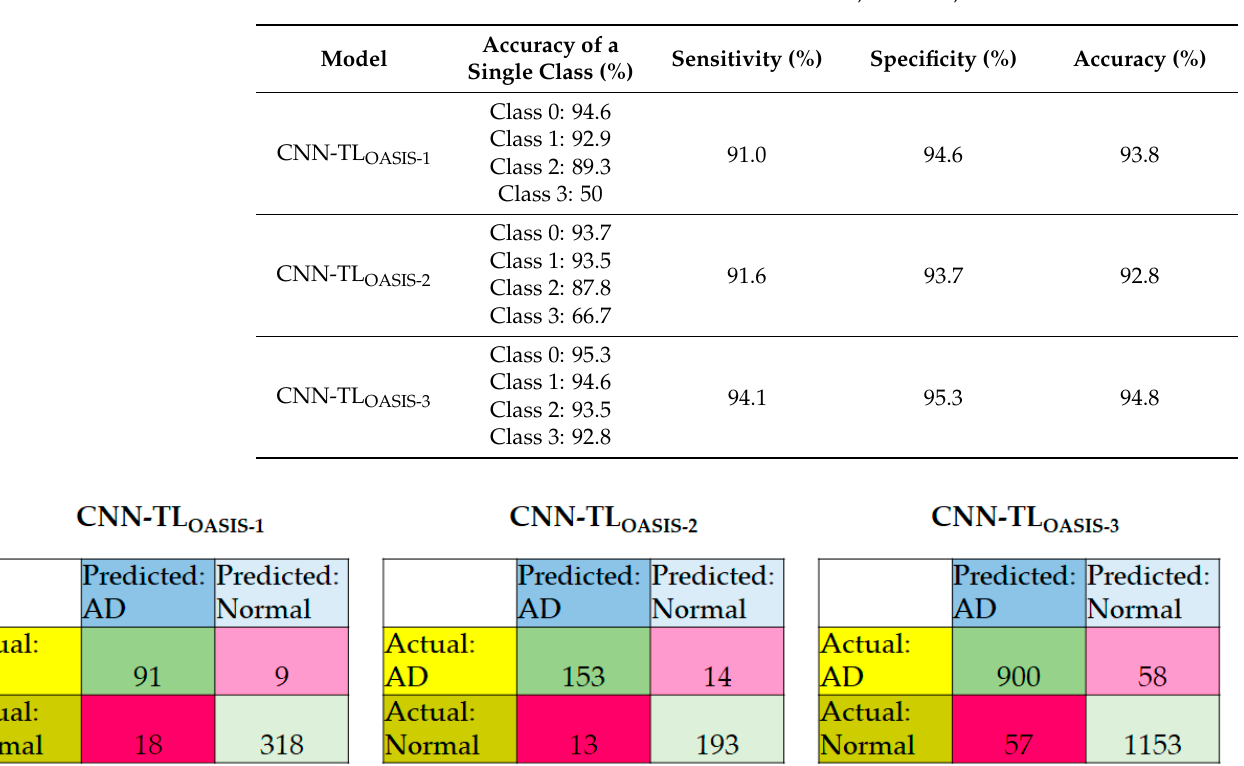
Table 3. Performance evaluation of the CNN-TL for OASIS-1, OASIS-2, and OASIS-3.